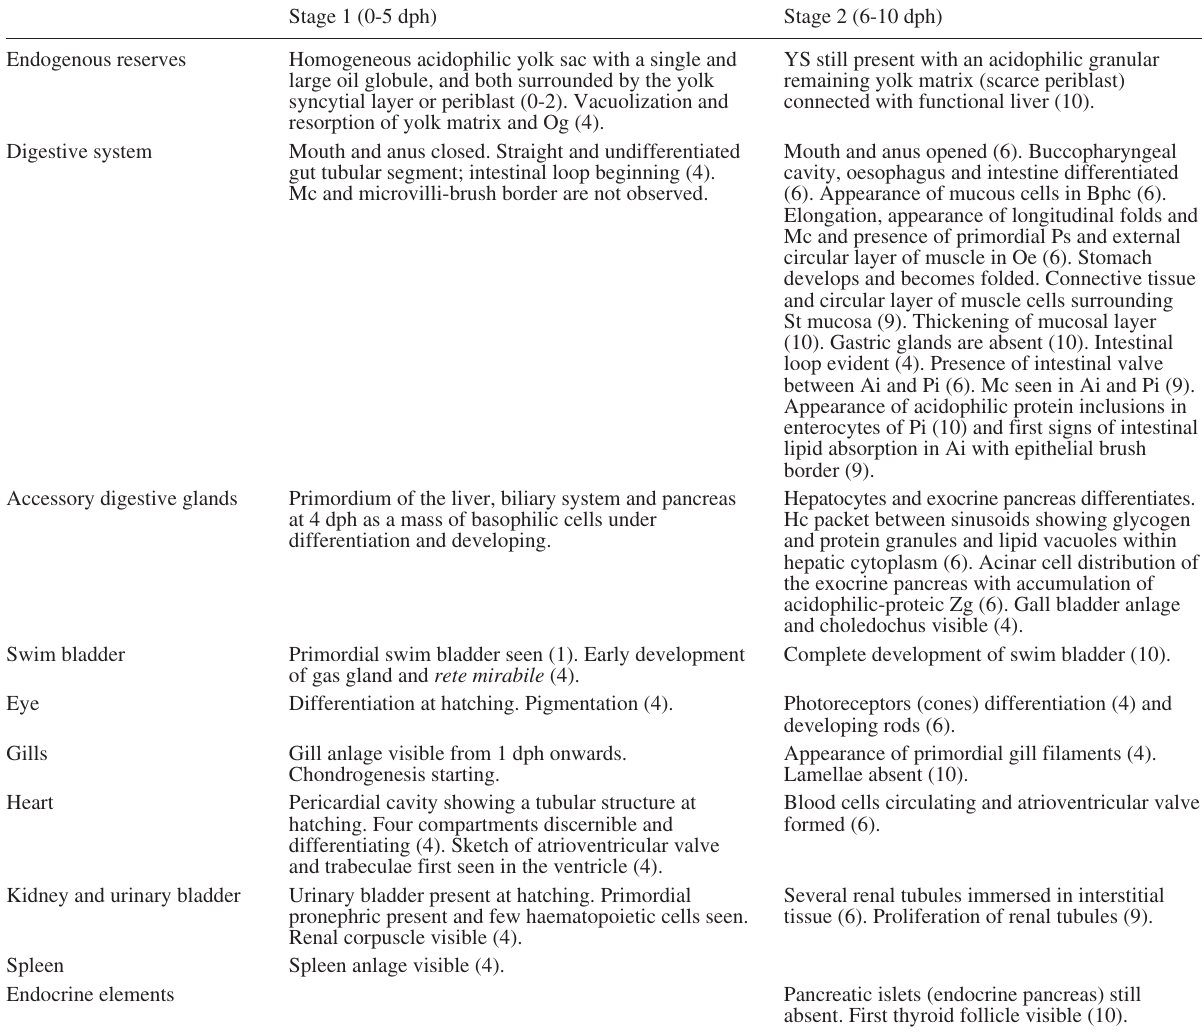
Table 1. – Schematic synthesis of the main ontogenetic events occurring in the European hake, Merluccius merluccius, larvae during endo- trophic (stage 1) and endo-exotrophic (stage 2) phases. Dph: days post-hatching; Ai: anterior intestine; Bphc: buccopharyngeal cavity; Oe, oesophagus; Og: oil globule; Mc: mucous cells; Pb: periblast; Ps: pyloric sphincter; St: stomach; Pi: posterior intestine; Hc: hepatocytes; Ep: exocrine pancreas; Tf: tyroid follicle: Ym: yolk matrix or yolk mass; YS: yolk sac; YSL: yolk syncytial layer; Zg: zymogen